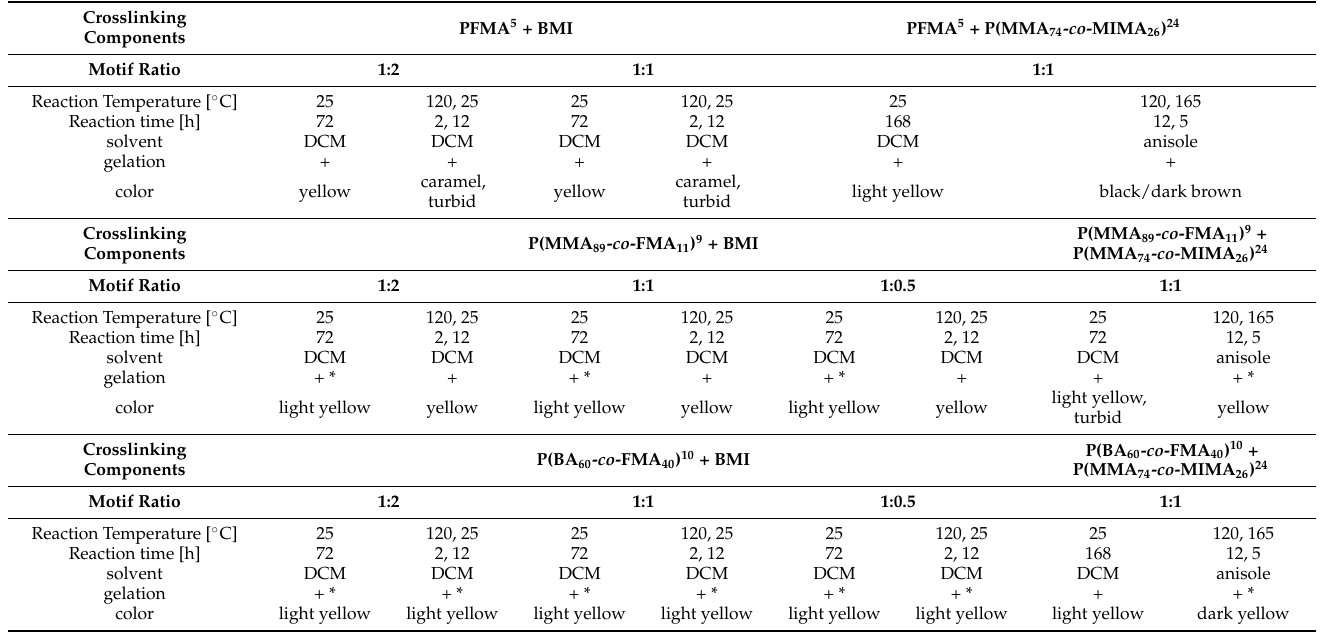
Table 2. Conditions for the crosslinking of the diene bearing components (PFMA 5 , P(MMA 89 - co -FMA 11 ) 24 , P(BA 60 - co - FMA 40 ) 10 ) with one of the dienophile-bearing components (BMI, P(MMA 74 - co -MIMA 26 ) 9 ) such as a motif ratio between diene and dienophile, rection time, and crosslinking temperature as well as visual gelation and color of the product. Gelation results marked with a star only showed gelation after removal of the solvent used during the crosslinking reaction. Crosslinking